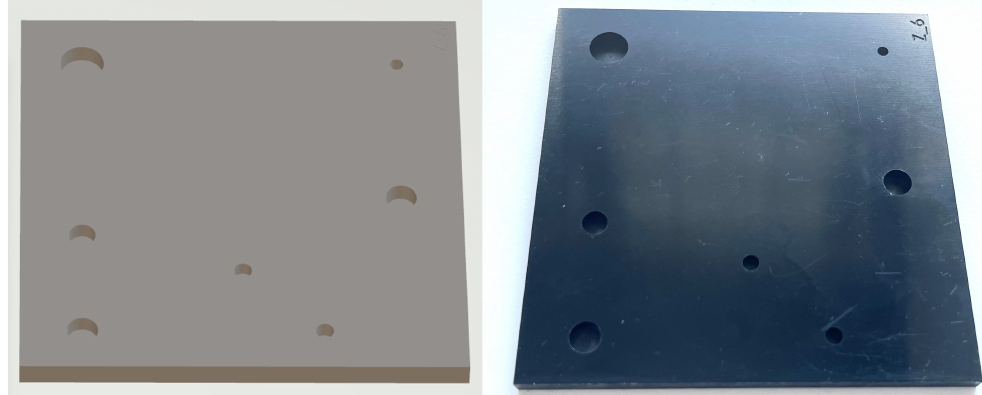
Figure 3. Images for a specimen, the left image is the CAD visualization, the right image is an optical image for it.